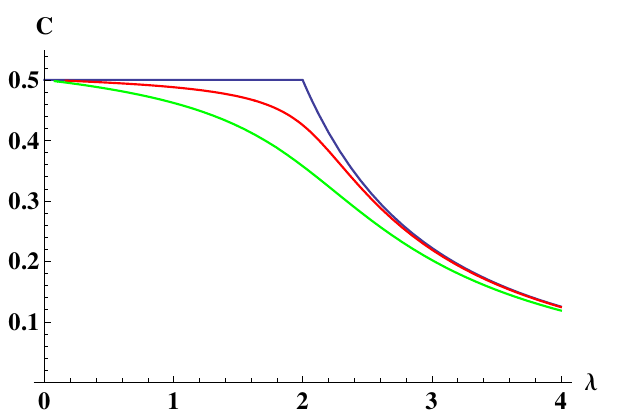
Figure 10 . Speci(cid:12)c heat C=N 2 = (cid:0) 2 @ (cid:21) W as a function of (cid:21) . From top to bottom, (cid:28) = 0, (cid:28) = 0 : 03 and (cid:28) = 0 :